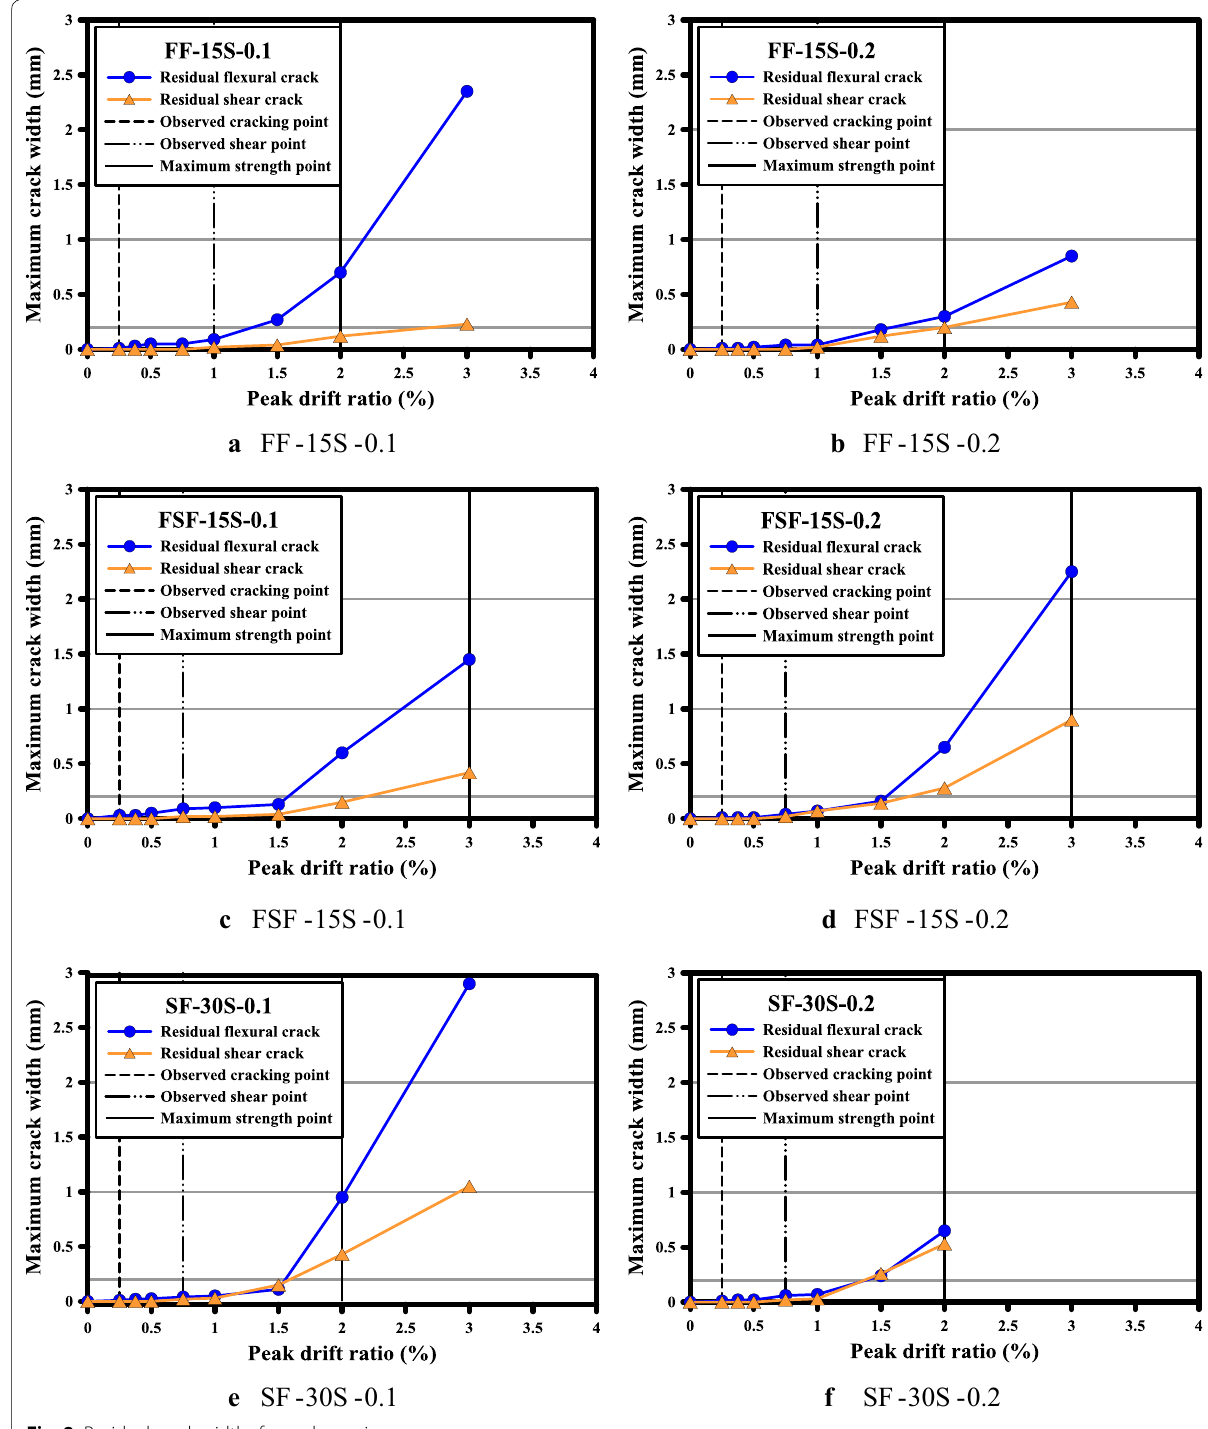
Fig. 8 Residual crack widths for each